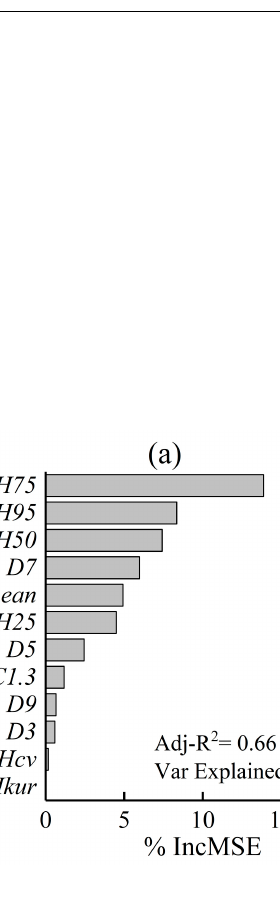
Table 5. Comparison of performance of individual tree segmentation using airborne-LiDAR.